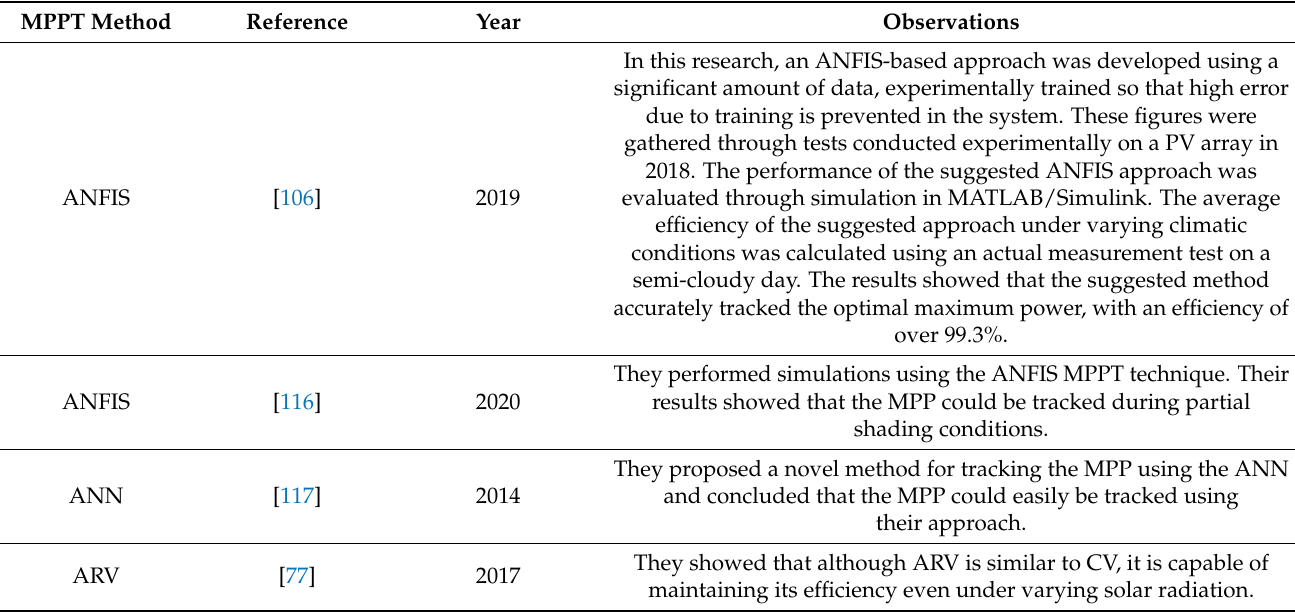
Table 6. Summary of related works for different MPPT